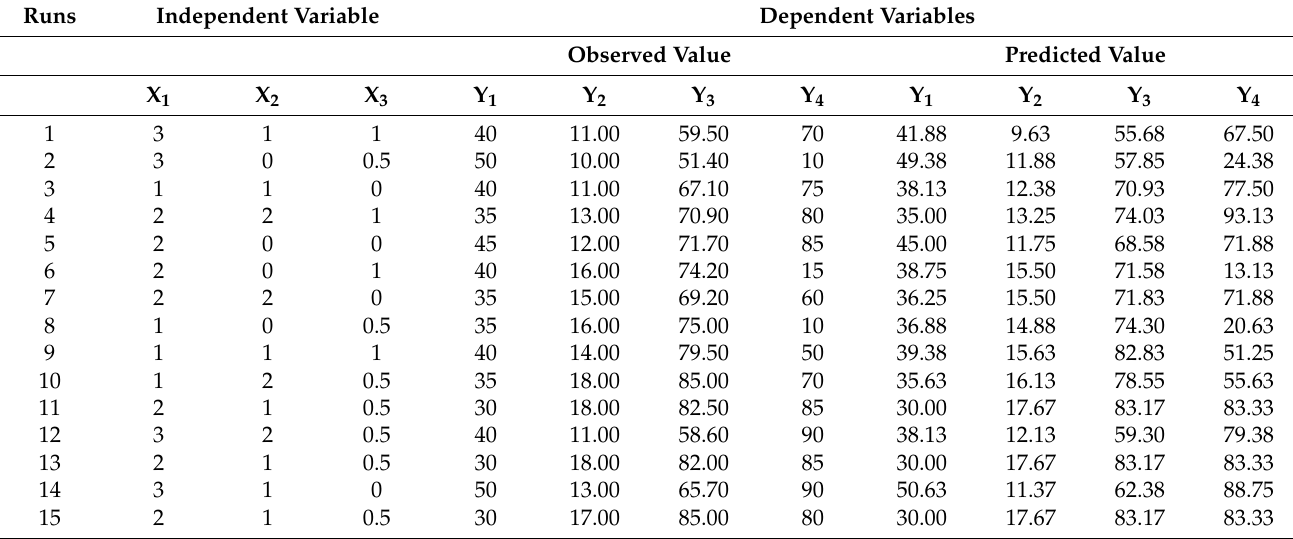
Table 3. Design (Box–Behnken) of experiments with